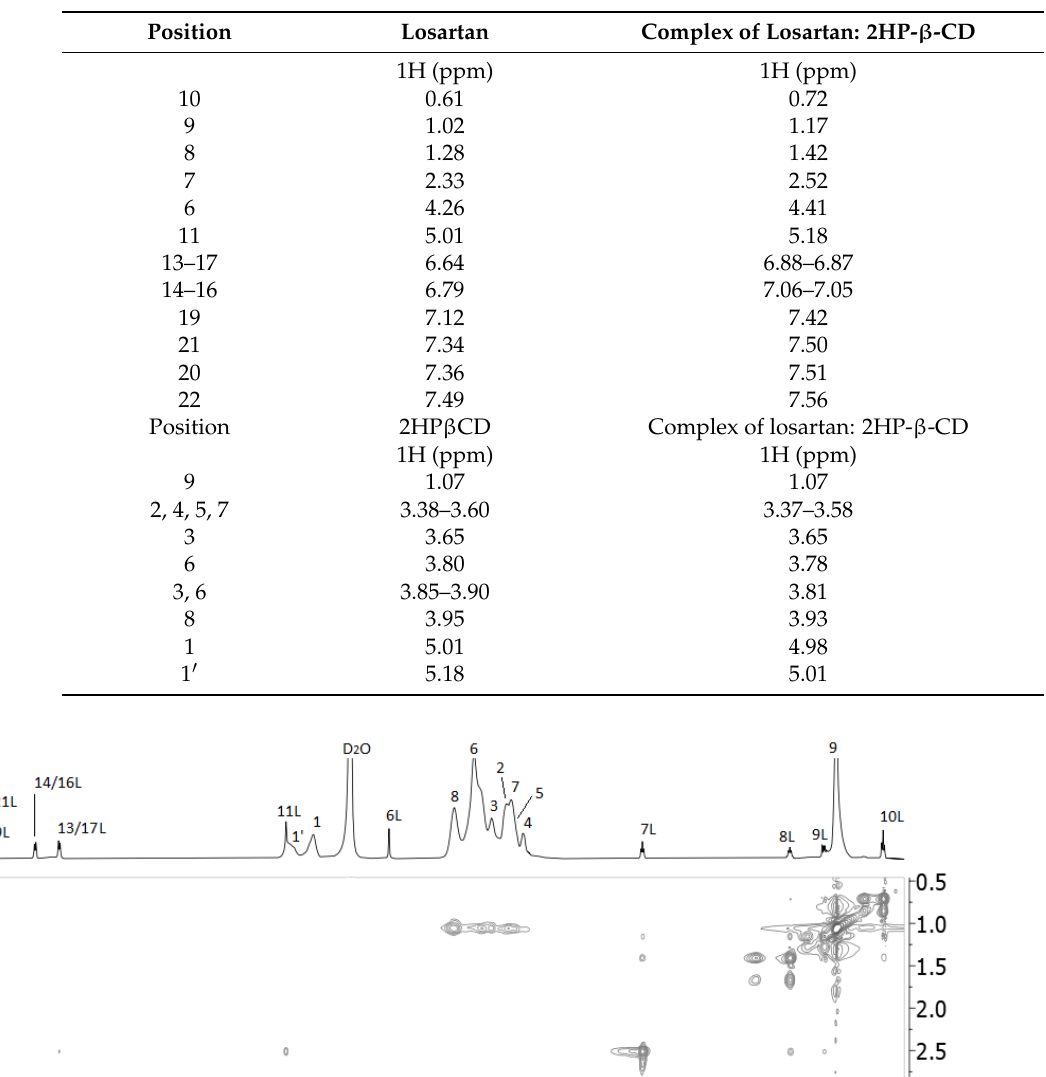
Table 2. In this table the chemical shift values of protons expressed in ppm of the three samples under study are shown; thus, losartan, 2HP- β -CD and the complex of losartan:2HP- β -CD.